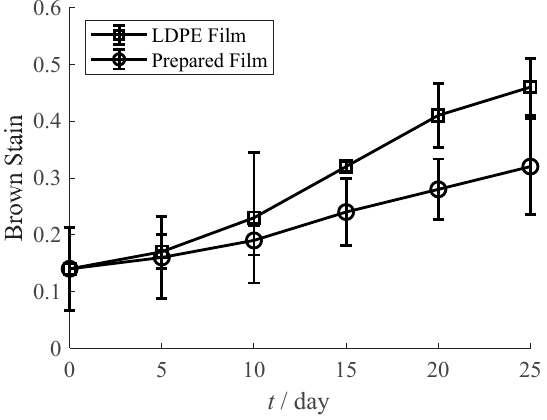
Figure 13. Brown stain of orange juice in LDPE film pouch and prepared film pouch.